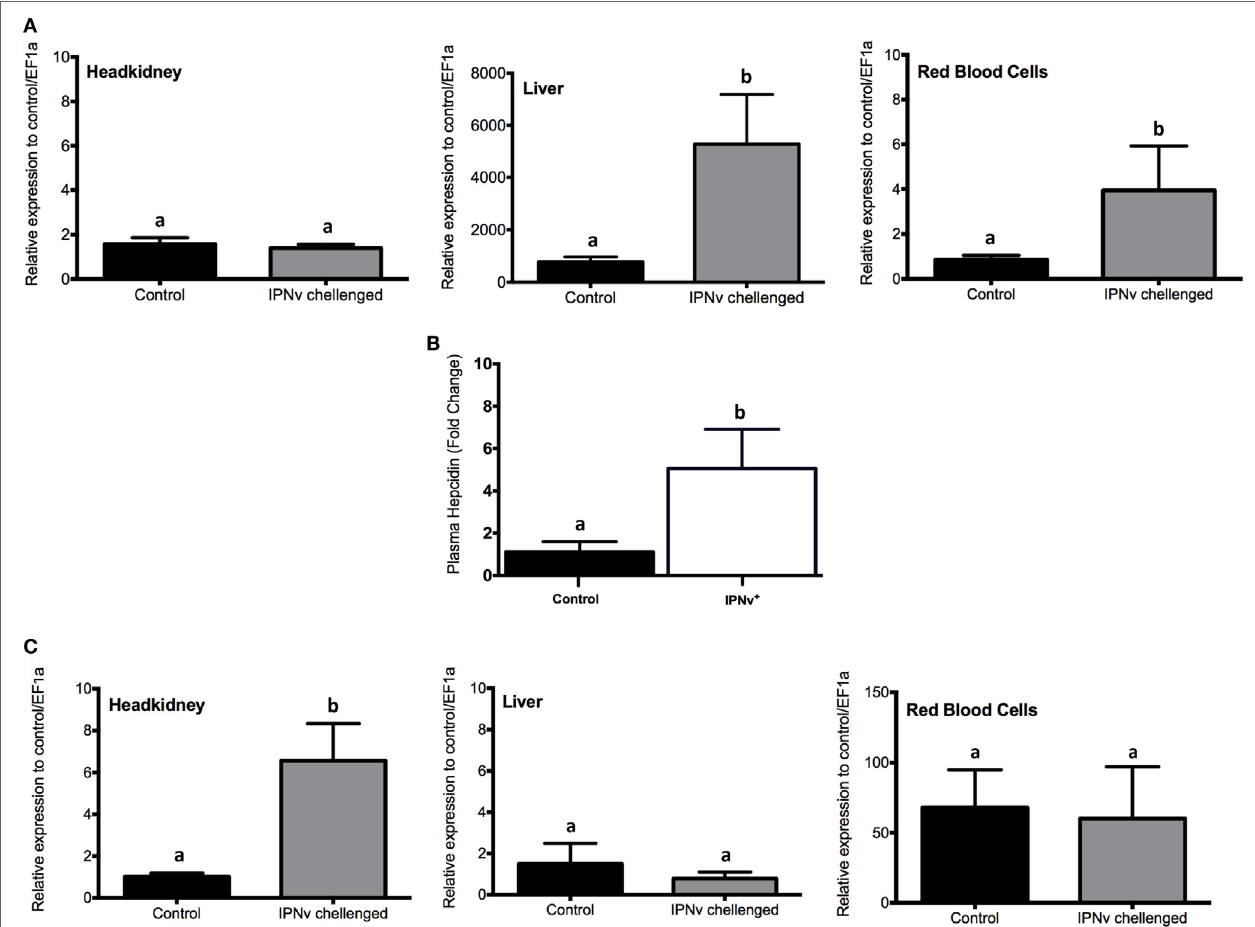
FigUre 7 | mRNA and protein expression profile of genes associated with the iron homeostatic response. Expression measured by qRT-PCR for (a) hepcidin, (c) heme oxygenase-1 from headkidney (left), Liver (middle), and red blood cells (right). (B) Plasma concentration (pg × mL − 1 ) of Cathelicidin. The experimental groups are: virus free (Control, black bar), IPNv challenged (gray bar). Values are represented as the mean mRNA/protein abundance ± SD. Different letters denote significant differences between groups (two-way ANOVA; p < 0.05; p <